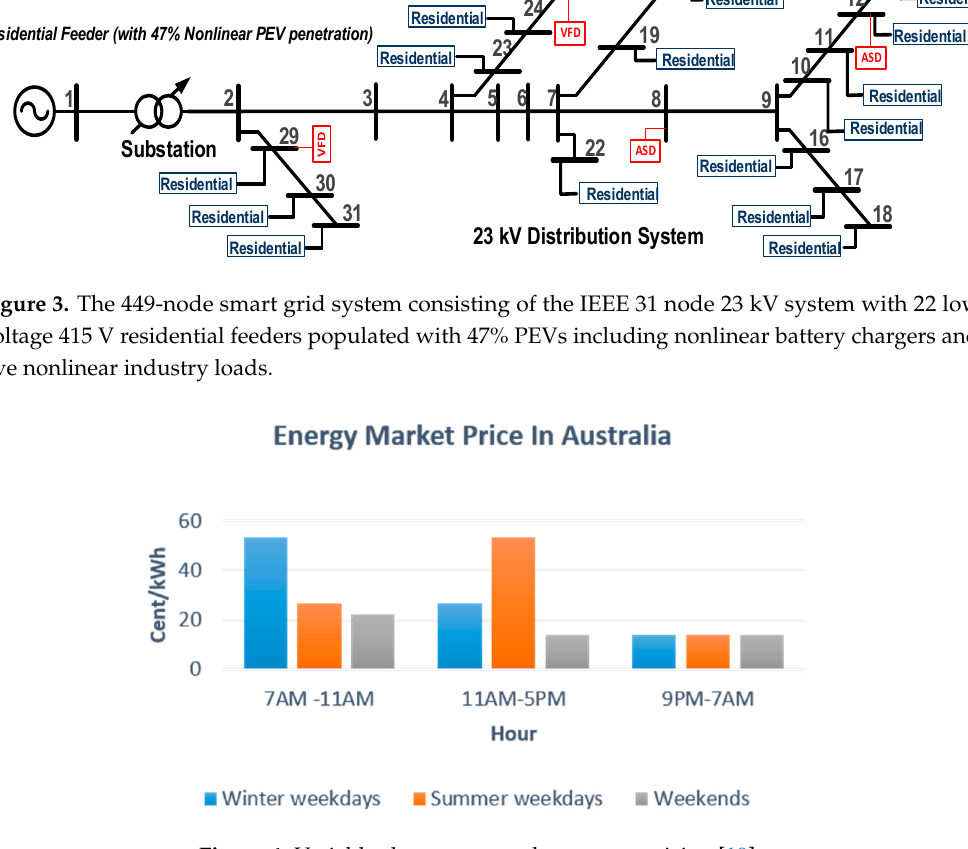
Figure 4. Variable short-term market energy pricing [19].